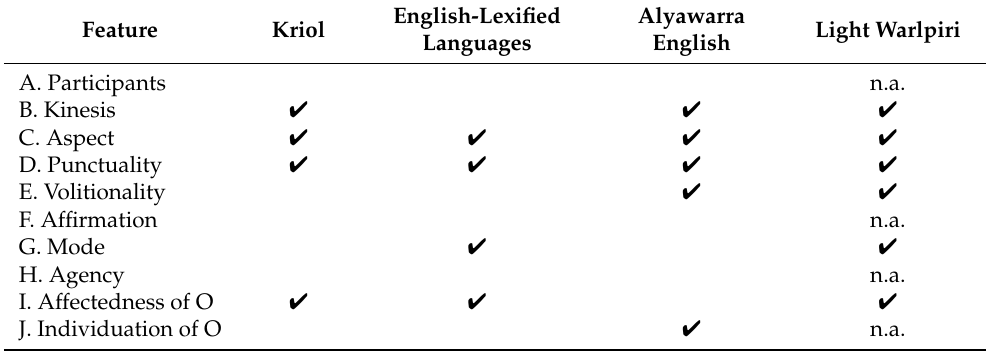
Table 5. Studies of contact languages in terms of Hopper and Thompson’s ten features of